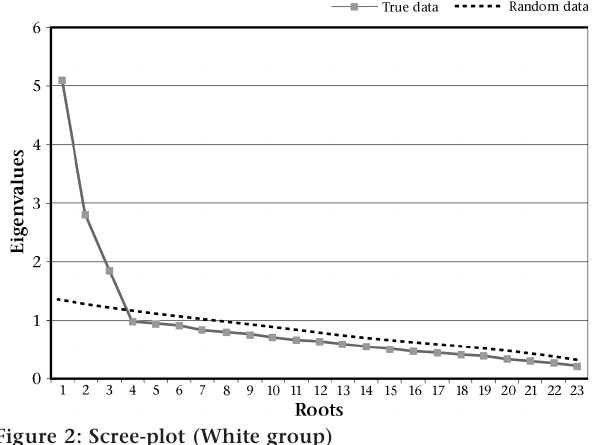
Figure 2: Scree-plot (White group) T ABLE 8 R OTATED PATTERN MATRIX FOR BLACK AND WHITE GROUPS Pattern Matrix (Black group) (n=376) Pattern Matrix (White group) (n=374) Factor